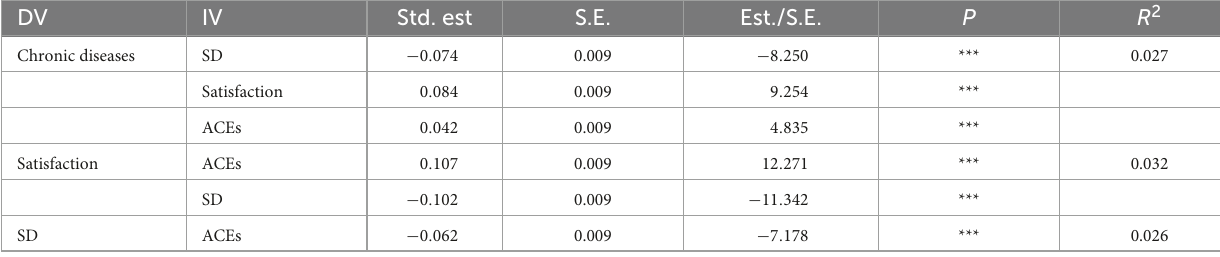
TABLE 9 Model regression weight of the impact of ACEs on the number of chronic diseases. DV IV Std. est